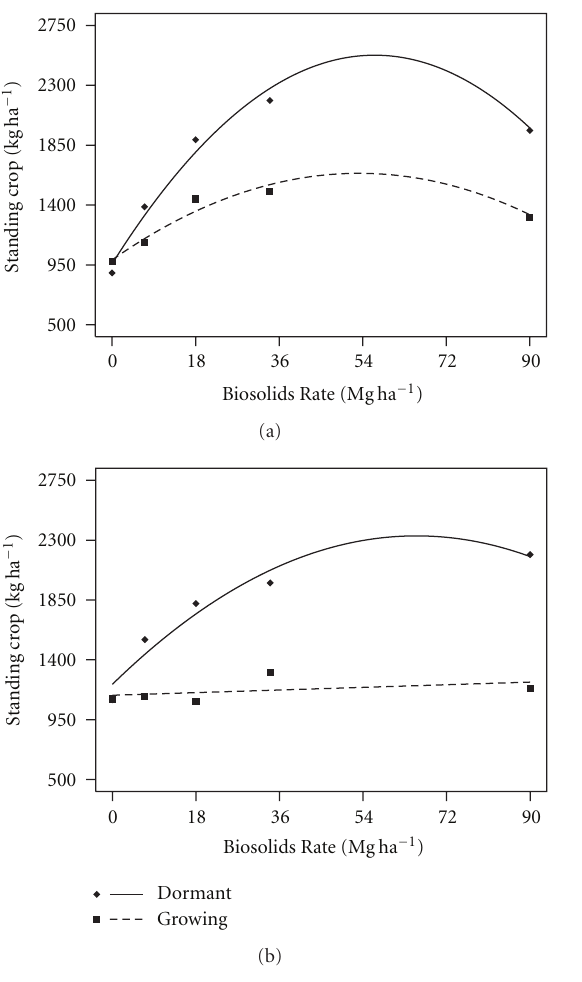
Figure 2: Standing crop (kgha − 1 ) of Hilaria mutica in (a) nonirrigated plots and (b) irrigated plots at the end of the 1996 growing season as a ff ected by one to four consecutive years of biosolids application and rate of biosolids application (redrawn from